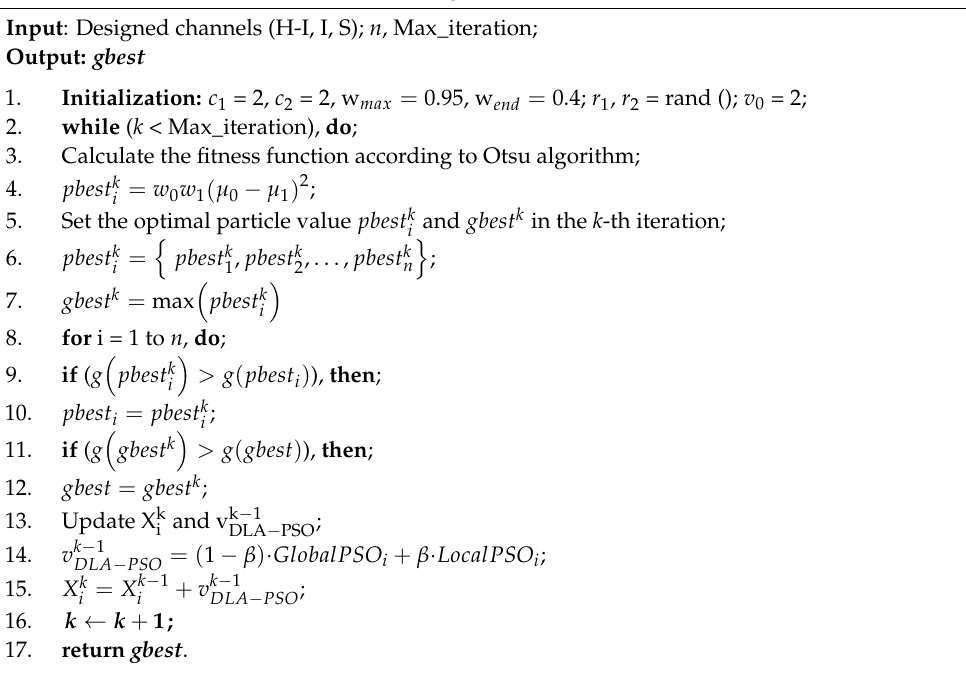
Algorithm 1: Framework of the DLA-PSO